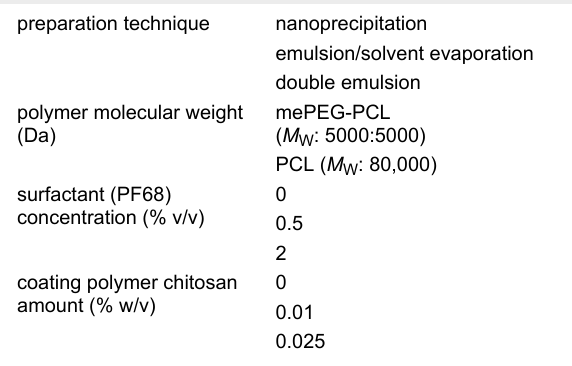
Table 4: Pre-formulation parameters for nanoparticle preparation. preparation